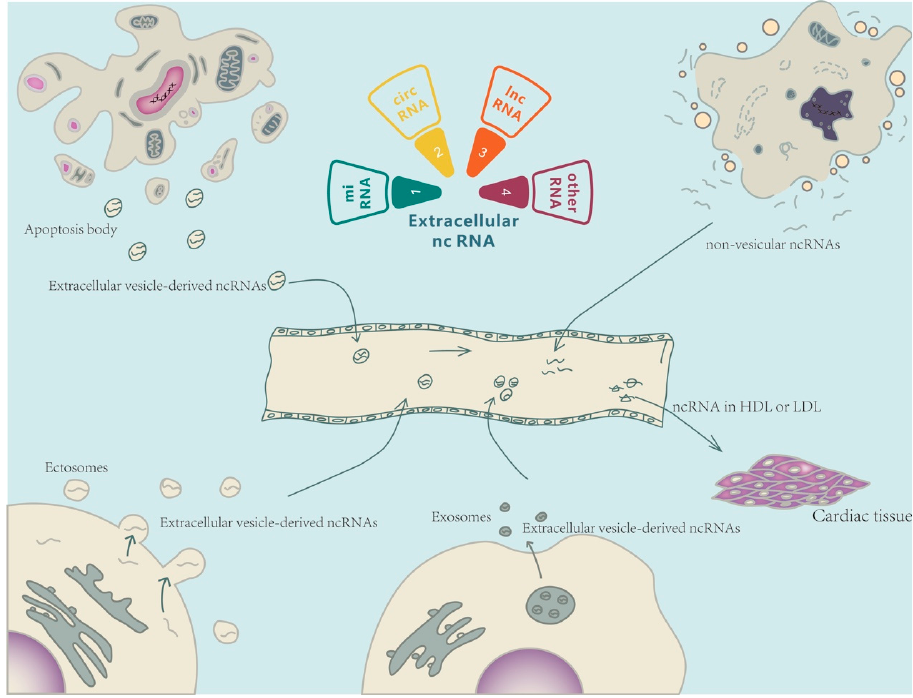
Figure 1. Extracellular non-coding RNA-mediated intercellular crosstalk. Extracellular non-cod- ing RNAs (Ex-ncRNAs) are a heterogeneous group of RNAs and mainly include small ncRNAs, lncRNAs, and circRNAs. Ex-ncRNAs can be translocated into receipt cells and modulate the cellular functions of targeted cells (heart or other cardiovascular systems). Ex-ncRNAs can be secreted